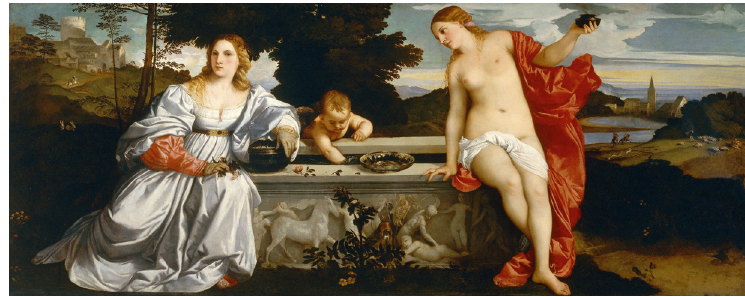
Figure 3.1 Titian, Sacred and Profane Love (c. 1514). Image public